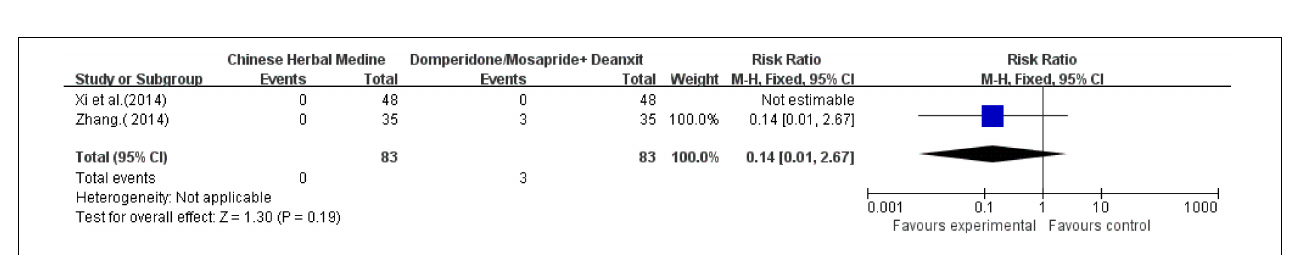
FIGURE 11 | Meta-analysis of adverse reactions of CHM and placebo.